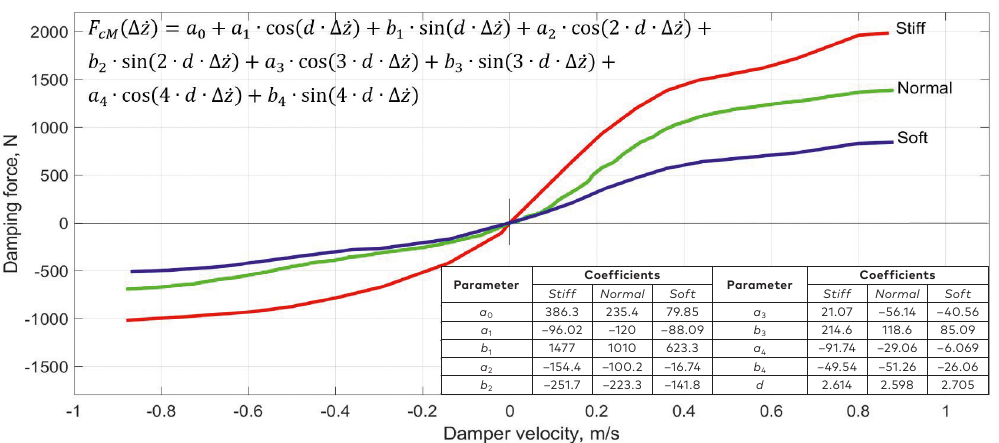
Figure 4. Semi-active shock absorber nonlinear damping characteristics with its mathematical description (Ślaski,